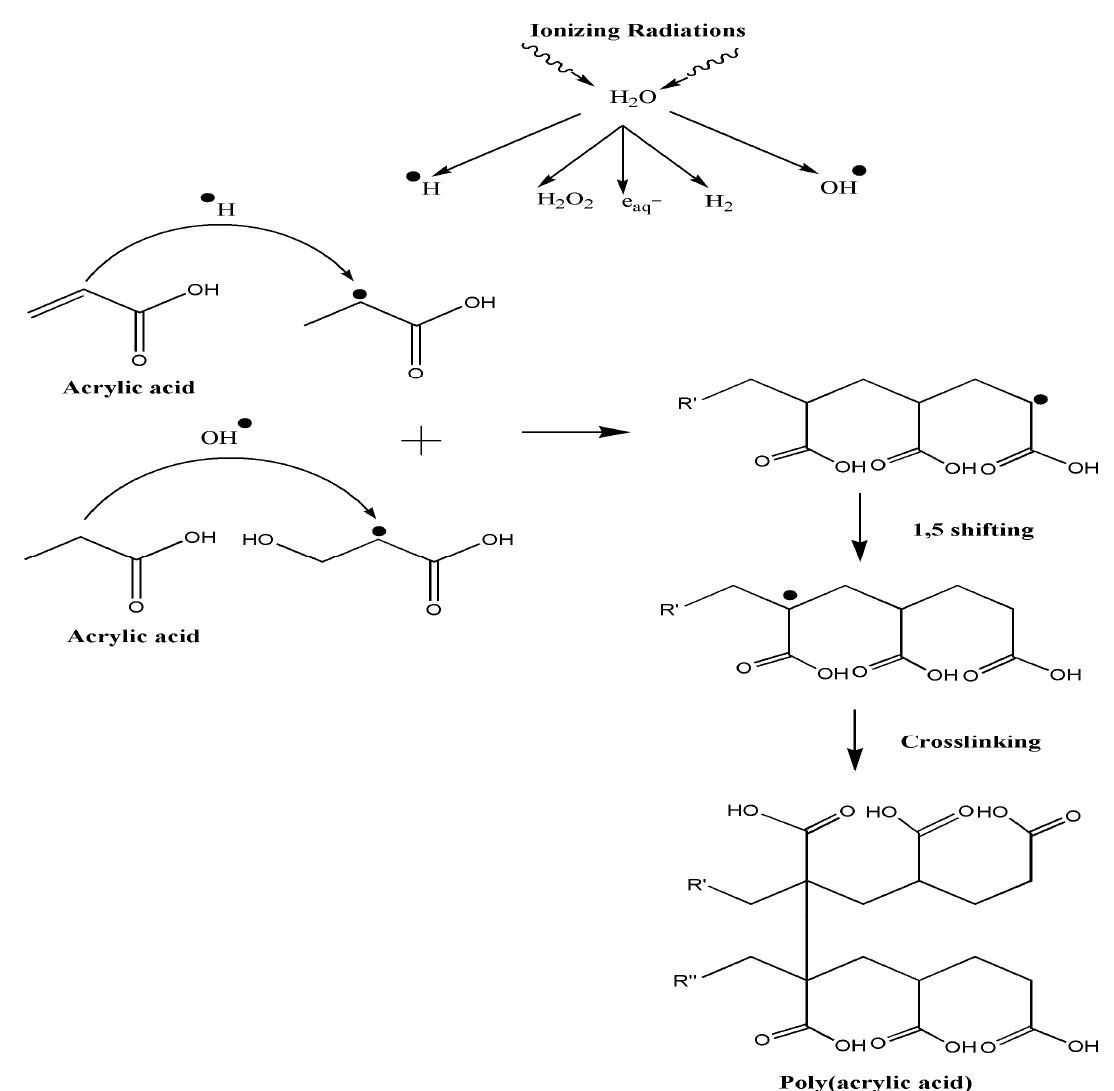
Figure 4. Reaction mechanism for PAA hydrogel synthesis [30].